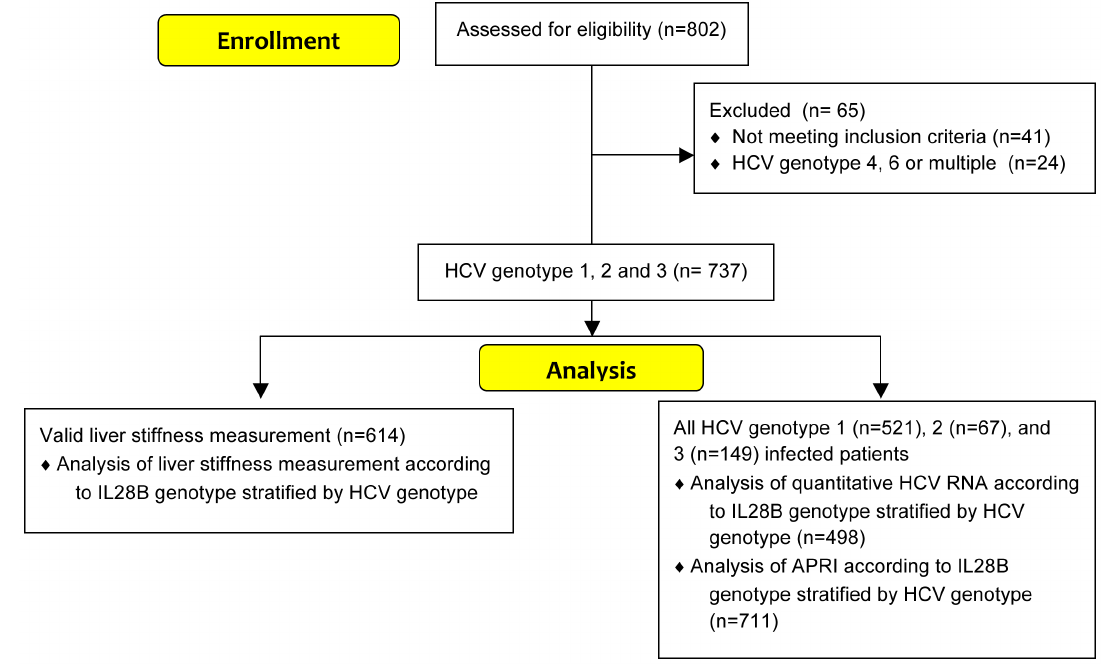
Figure 1. Study enrollment and disposition of patients.